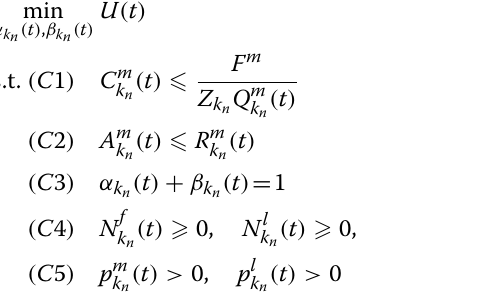
( t ) , respectively. Notice that, parts of data pack- and E l 2 k n ets will be dropped when the delay constraint can not be satisfied, and the associated energy consumption is not included in the total energy consumption